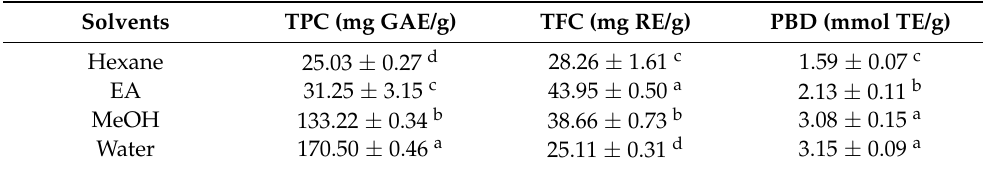
Table 1. Total bioactive compounds and total antioxidant capacity (by phosphomolybdenum assays) of the tested